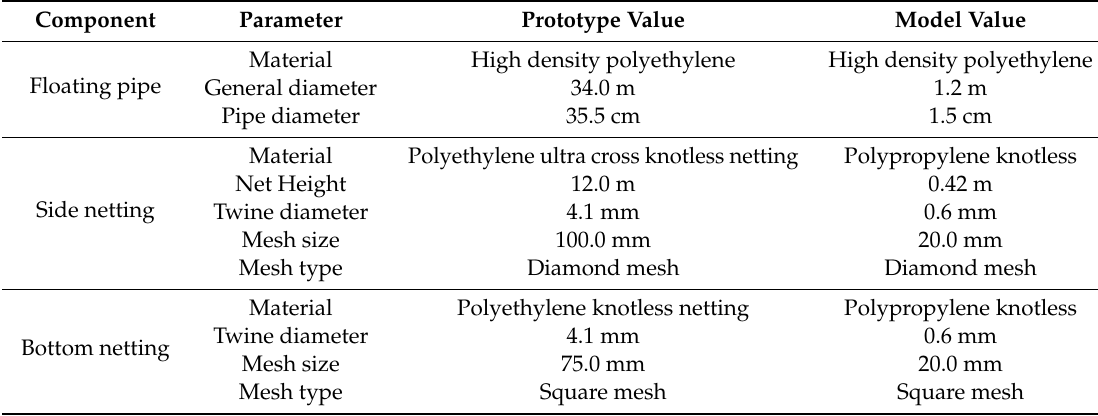
Table 1. The Specifications of full-scale net cage and model net